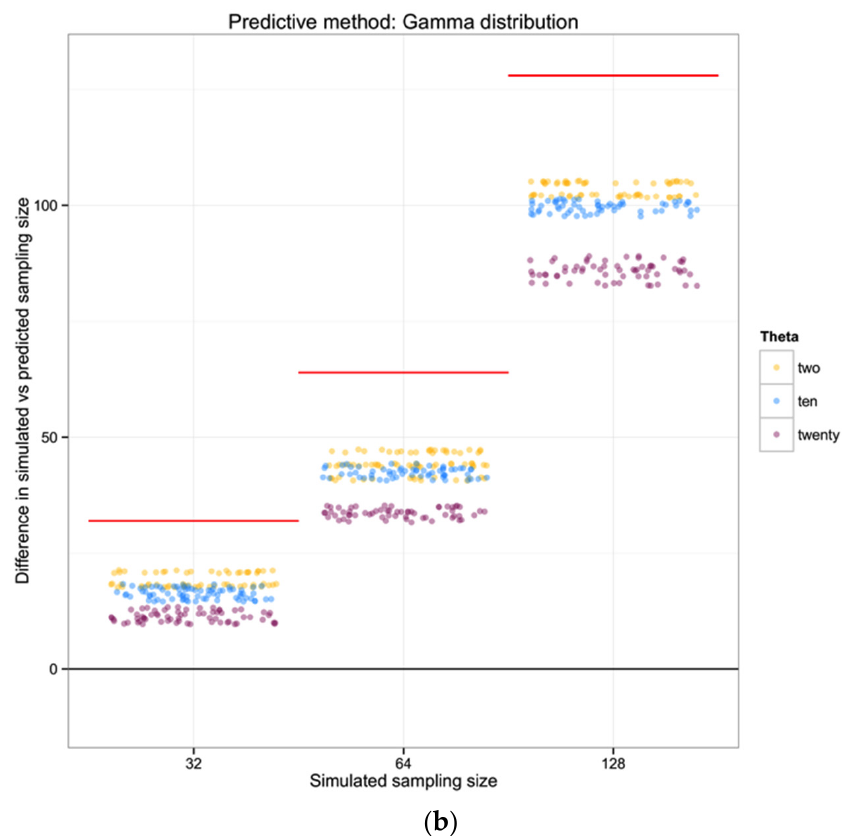
Figure 3. Difference between the simulated sampling size and the predicted sampling size using the gamma distribution method. ( a ) sampling sizes of 2, 4, 8 and 16; ( b ) sampling sizes of 32, 64 and 128. The horizontal line at zero shows the ideal situation with the estimation equal to the simulated sampling size. The red lines show the limit where the difference between simulated and predicted equals the sampling size; that is, beyond the red lines the error is too large to make a sensible prediction. Please note that the data are jittered to enhance visualization, and that the y-axes differ between ( a ) and ( b ).